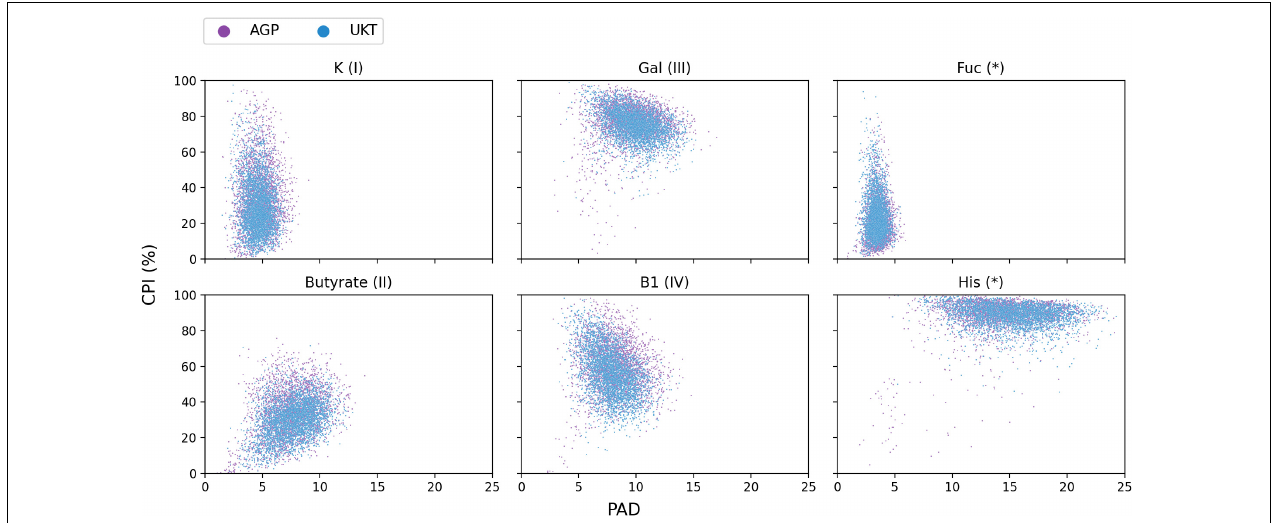
FIGURE 6 | CPI-vs.-PAD scatterplots for six selected metabolic phenotypes calculated for the AGP and UKT datasets.